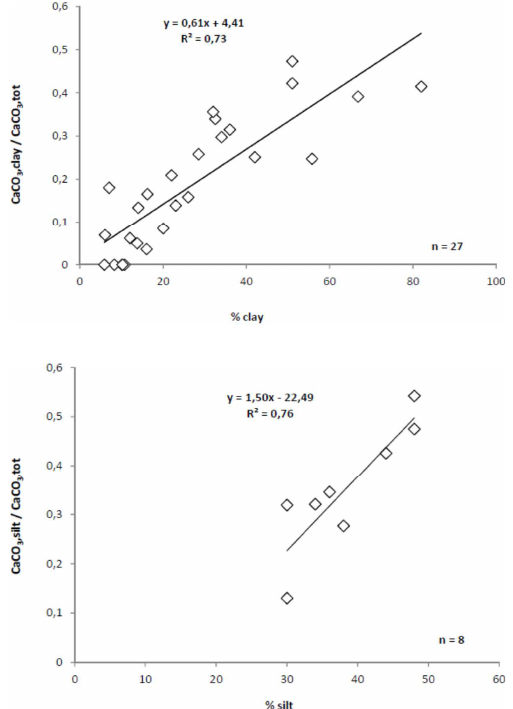
Figure 2: Empirical relationships (a) between the percentage of calcite in the clay fraction and the ratio of the calcite in the clay fraction to the clay content of the soil (b) and between the percentage of calcite in the silt fraction and the ratio of the calcite in the silt fraction to the total calcite content of the soil (right). 710